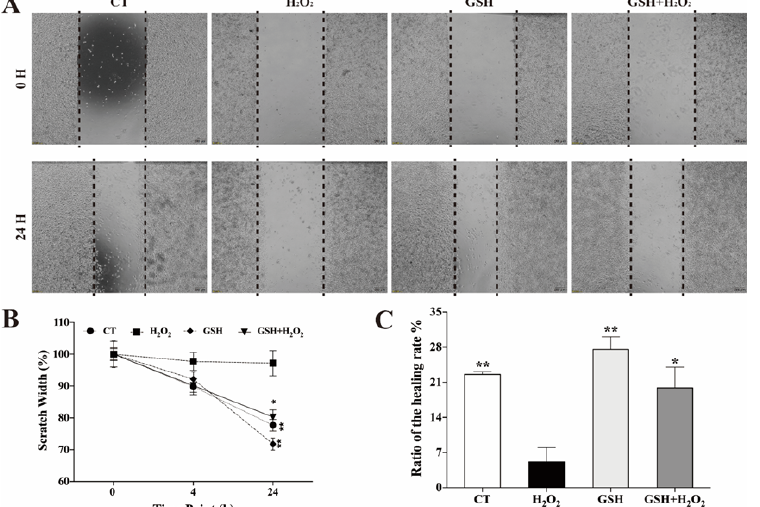
Figure 2. Effect of GSH on the cell migration capacity of IPEC-J2. ( A ) Representative image of wound-healing assay. The dashed lines indicate wound edges. After scratching, cells were pretreated with or without H 2 O 2 (500 µ M) for 24 h. Afterwards, the culture medium was removed, replaced with fresh medium with or without GSH (1.6 mM) and incubated for another 24 h. Scale bar: 200 µ m. ( B ) Quantification of migrated scratch width at different time point. Values are presented as the mean±SD ( n = 3). * p < 0.05 vs . H 2 O 2 -treated group at the same time point. ( C ) Quantification of the healing rate. The healing or closure rate is expressed as a ratio of the migration distance (after 24 h) compared with the distance immediately after scratching. Values are presented as the mean ± SD ( n = 3). ** p < 0.01 compared with the H 2 O 2 -exposed